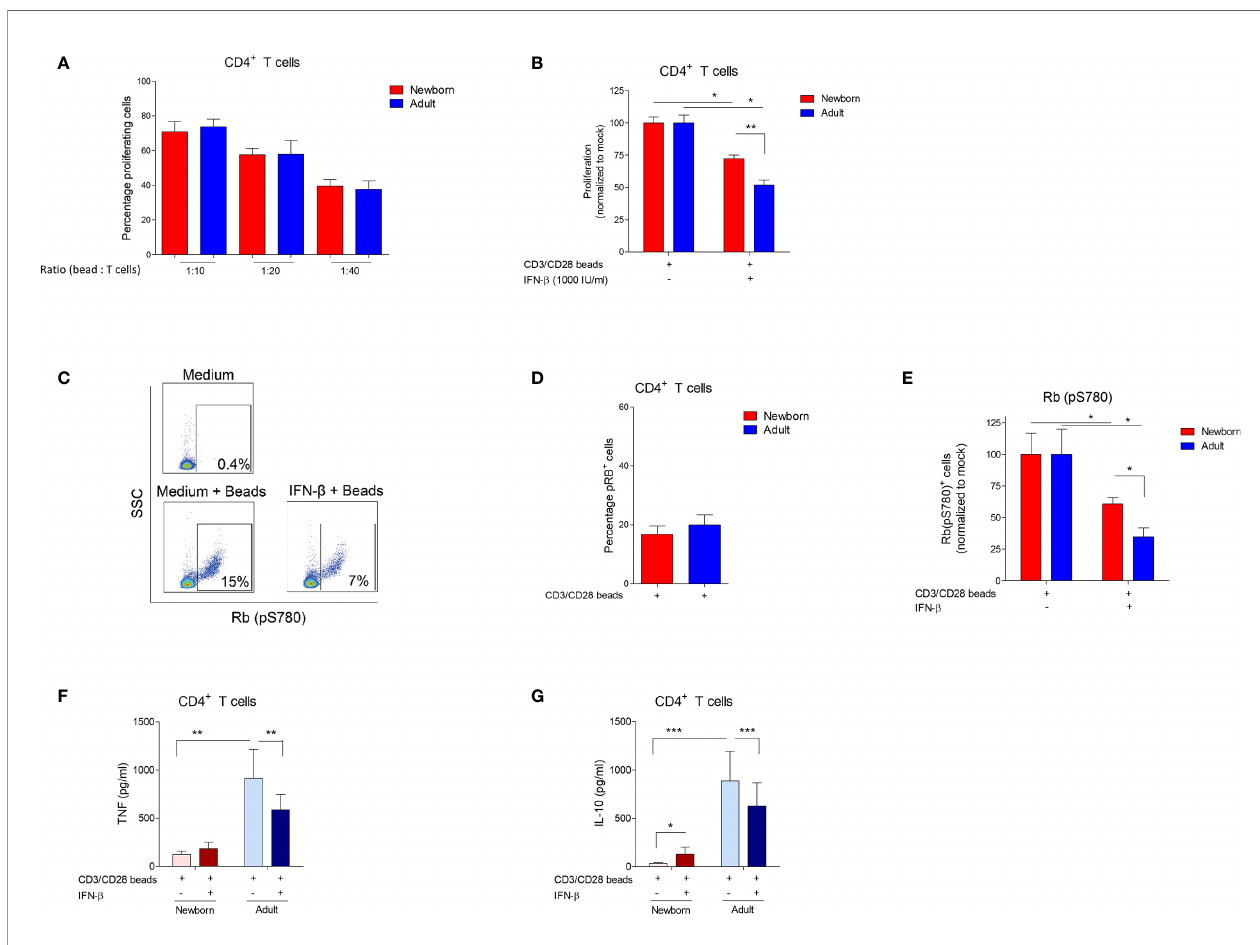
FIGURE 2 | IFN- b -mediated inhibition of bead-induced CD4 + T cell proliferation, phosphorylation of Rb and cytokine production is reduced in newborns. (A) Percentage of proliferating CD4 + T cells after incubation of isolated adult and newborn CD4 + T cells with CD3/CD28 beads for 72h. (N=6-8). (B) Newborn and adult CD4 + T cells were pre-incubated with medium, or IFN- b for 24h and, subsequently, incubated with CD3/CD28 beads for 72h to induce proliferation. Proliferation after pre-incubation with medium was set to 100%. (N=6-8). (C) Representative gating strategy: CD4 + T cells were isolated from PBMC or CBMC and phosphorylation of Rb was determined. (D) Percentage of CD4 + T cells positive for Rb phosphorylation after incubation of isolated adult and newborn CD4 + T cells with CD3/CD28 beads for 72h. (E) Newborn and adult CD4 + T cells were pre-incubated with medium, or IFN- b for 24h and, subsequently, incubated with CD3/ CD28 beads for 72h to induce phosphorylation of Rb. Phosphorylation of Rb after pre-incubation with medium was set to 100%. (F, G): Newborn and adult CD4 + T cells were pre-incubated with medium, or IFN- b for 24h and, subsequently, incubated with CD3/CD28 beads for 72h to induce cytokine production of TNF (F) and IL-10 (G) . Data are presented as means ± SEM. * = P <0.05. ** = P <0.01. *** = P